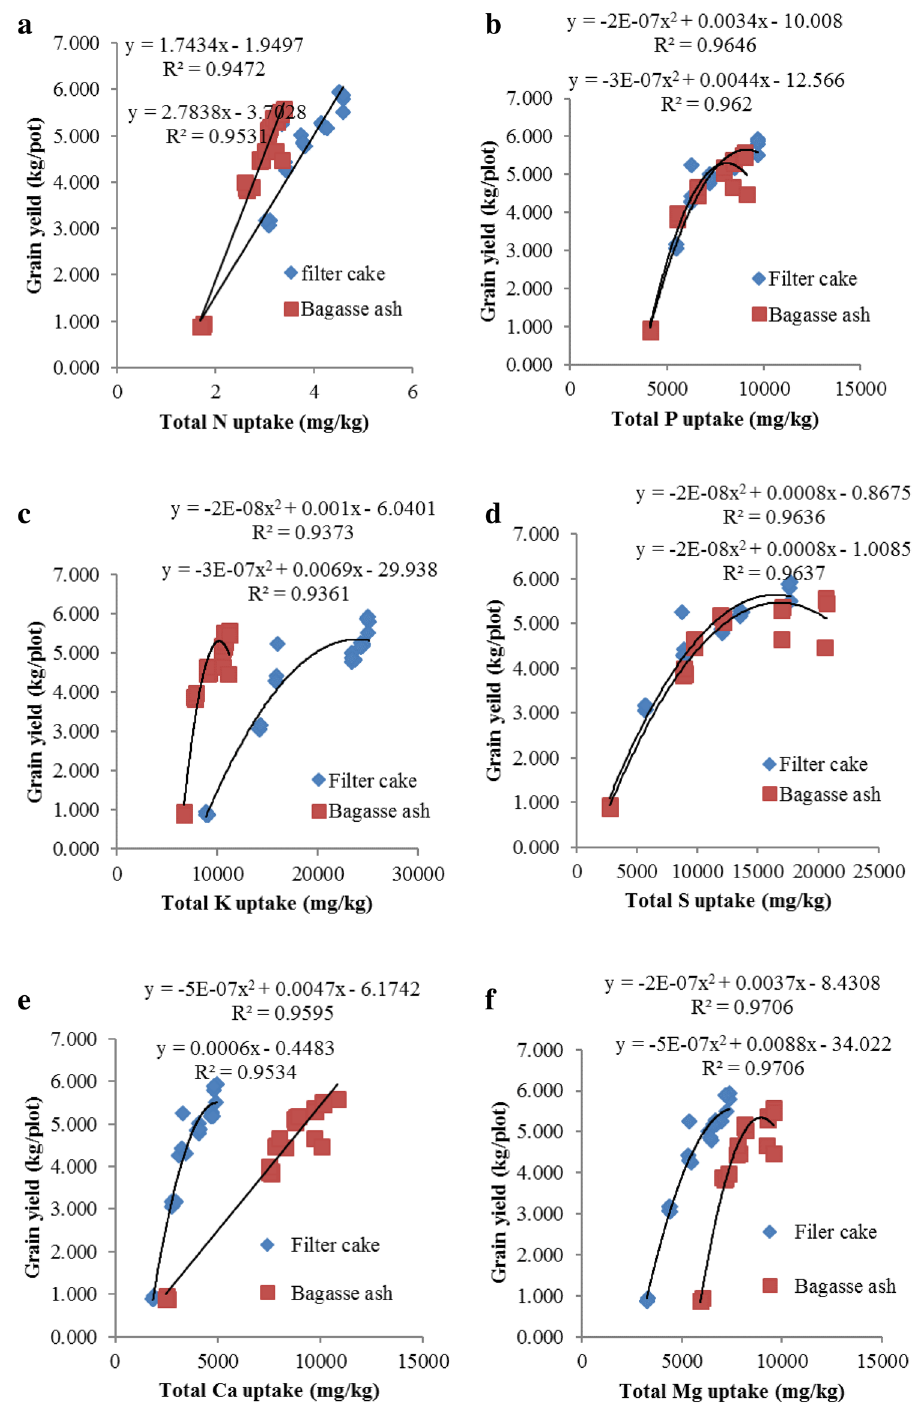
Fig. 1 Effect of filter cake and bagasse ash application rates on a Total N uptake, b Total